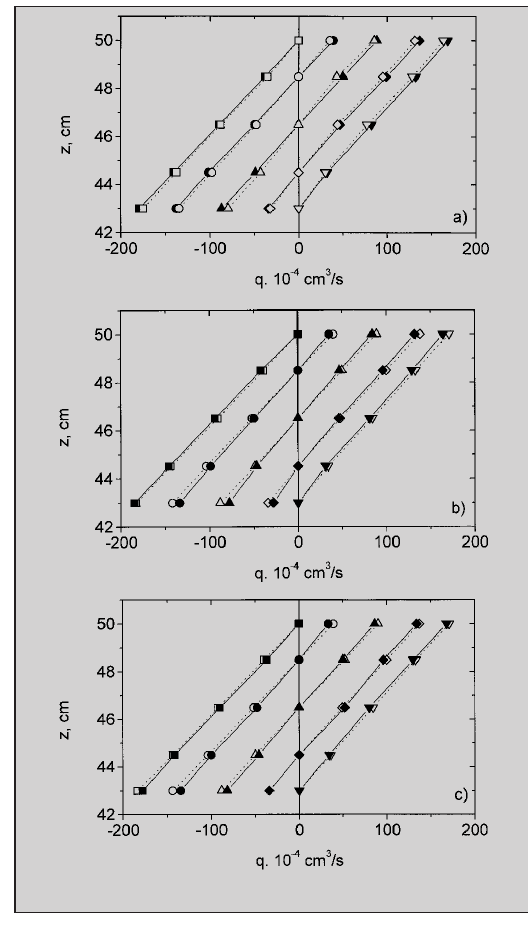
Figure 7: Comparison of the results obtained from the viscous (full symbols) and mathe- matical (open symbols) model for drainage pipe distance: a) 10